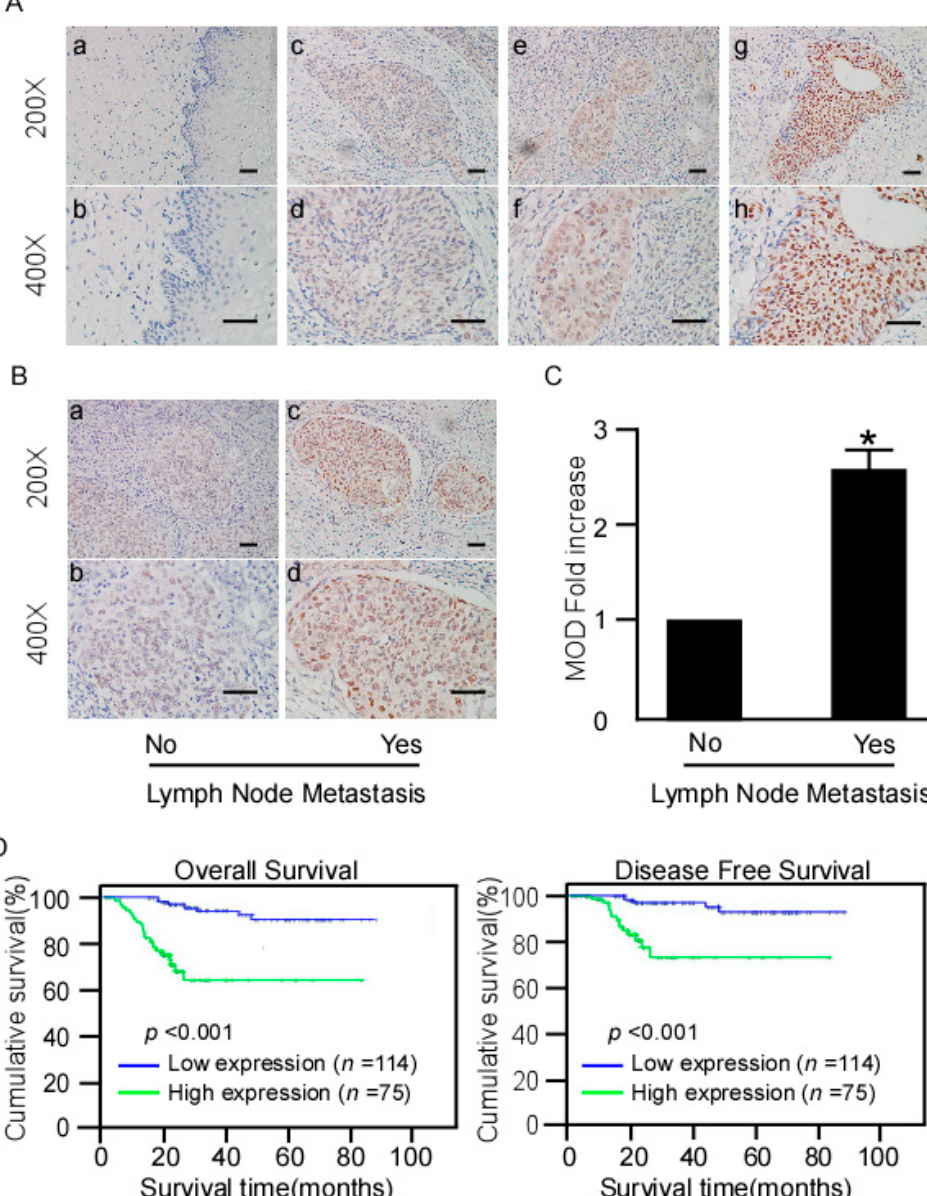
Figure 3. IHC detection of NR2F6 protein expression in paraffin-embedded cervical cancer tissues. Positive NR2F6 staining was observed mainly in the nuclei. ( A ) ( a , b ) NR2F6 expression was not detected in normal cervical tissues; ( c , d ) representative images of weak NR2F6 staining in cervical cancer tissues; ( e , f ) representative images of moderate NR2F6 staining in cervical cancer tissues; ( g , h ) representative images of strong NR2F6 staining in cervical cancer tissues(scale bars = 50 µ m); ( B , C ) Statistical analyses of the average MOD (mean optical density) of NR2F6 staining in the LNM (Lymph node metastasis) and LNM-free groups. Scale bars = 50 µ m, * p < 0.05; ( D ) Kaplan–Meier curves of univariate analysis data (log-rank test) showing the OS (overall survival) and DFS (disease-free survival) for patients with high versus low NR2F6 expression.